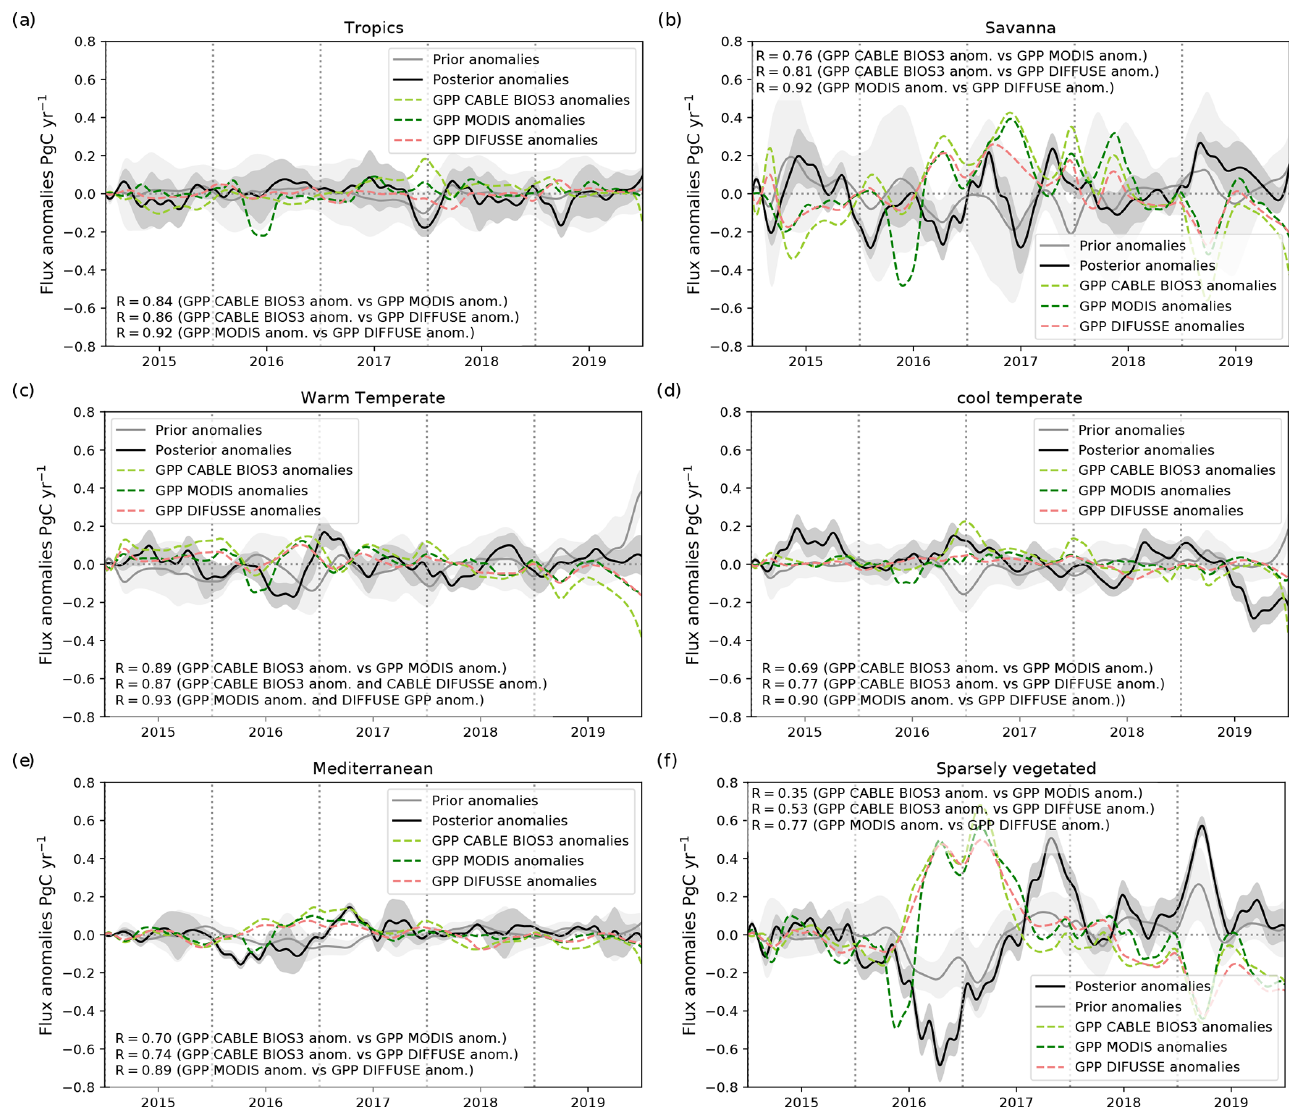
Figure C2. Time series of the 3-month running mean GPP anomalies derived from the CABLE BIOS3 model (light green dashed line), MODIS (dark green dashed line), and the DIFFUSE model (orange dashed line) between 2015 and 2019.